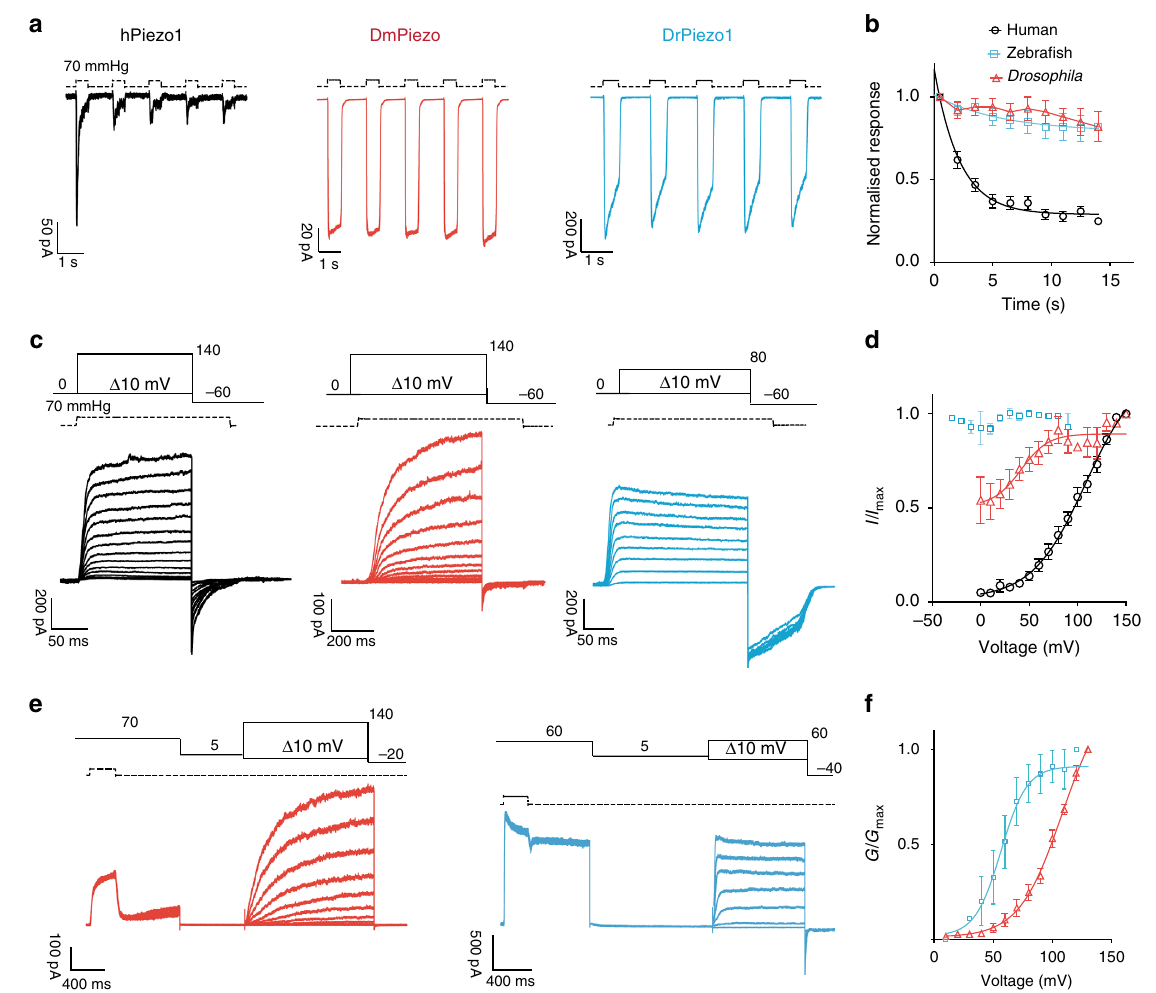
Fig. 7 Properties of human, Drosophila and zebra fi sh PIEZO1. a Five pulses of saturating pressures at − 60 mV were applied to patches pulled from N2a Piezo1 − / − expressing the human (black, n = 8), Drosophila (red, n = 5), and zebra fi sh PIEZO1 (blue, n = 9). b Current amplitudes were normalized to the fi rst-pressure pulse and plotted against time. Pooled data are shown as mean ± SEM. c Current responses to a pressure stimulation of 70 mmHg during 300 ms voltage steps ranging from 0 to 140 mV, followed by a repolarization step to − 60 mV to obtain tail currents. d Tail currents from individual cells were normalized to their maximum and fi tted to the Boltzmann relationship (human V 50 = 96.7 ± 4.8 mV, slope 19.9 ± 0.9, 5 cells; Drosophila V = 40.0 ± 9.8 mV, slope 12.1 ± 3.9, 7 cells). Note how the pressure-mediated currents of the zebra fi sh PIEZO1 are insensitive to voltage. Pooled data are 50 shown as mean ± SEM. e Same stimulation protocol as in Fig. 6b for DmPIEZO (red) and DrPIEZO1 (blue). f Macroscopic conductance values were normalized to maximum conductance and plotted against voltage to obtain a G / V curve. DmPIEZO did not reach saturation at voltages as high as 140 mV, while DrPIEZO had V 50 of 20.2 ± 6.8 mV and a slope of 7.9 ± 1.3 ( n = 7). (See also Supplementary Figs 2, 5 and